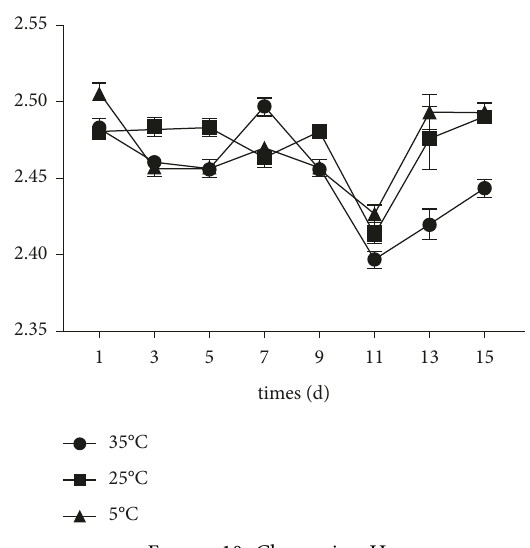
Figure 10: Change in